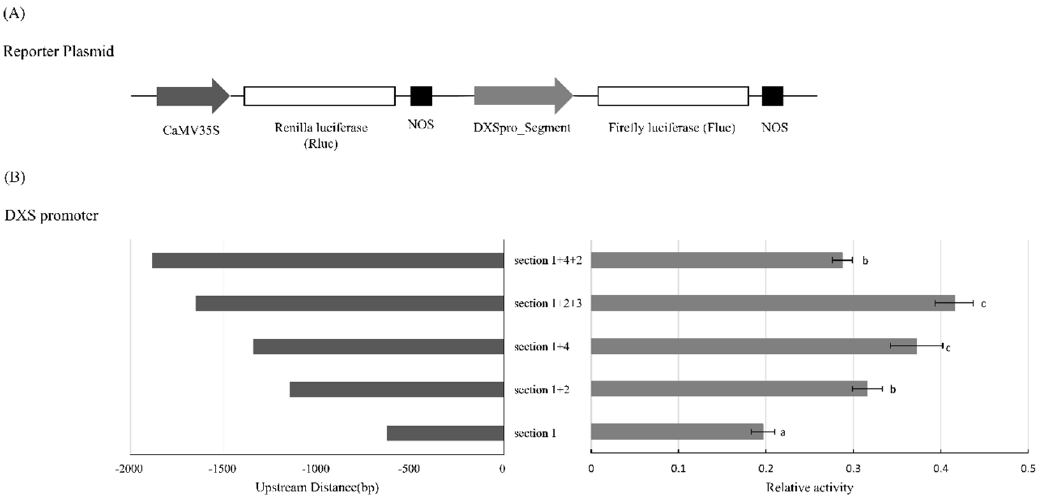
Figure 2. Transformation of Poa pratensis protoplasts with different segment of DXS1 promoter region fused to firefly luciferase ( Fluc ). ( A ) Schematic representation of DXSpro_segment: Fluc vector construction. CaMV 35S: Renilla luciferase ( Rluc ) served to the normalized control, NOS is the terminator; ( B ) the left presents the length of different segment or combination in the DXS1 promoter region. The right is the presence of relative Fluc activity (normalized by Rluc activity), as the segment_1 set to control. Data represent the average value with standard error of three biological replicates. Different letters above the bars indicate significant difference ( p < 0.05).